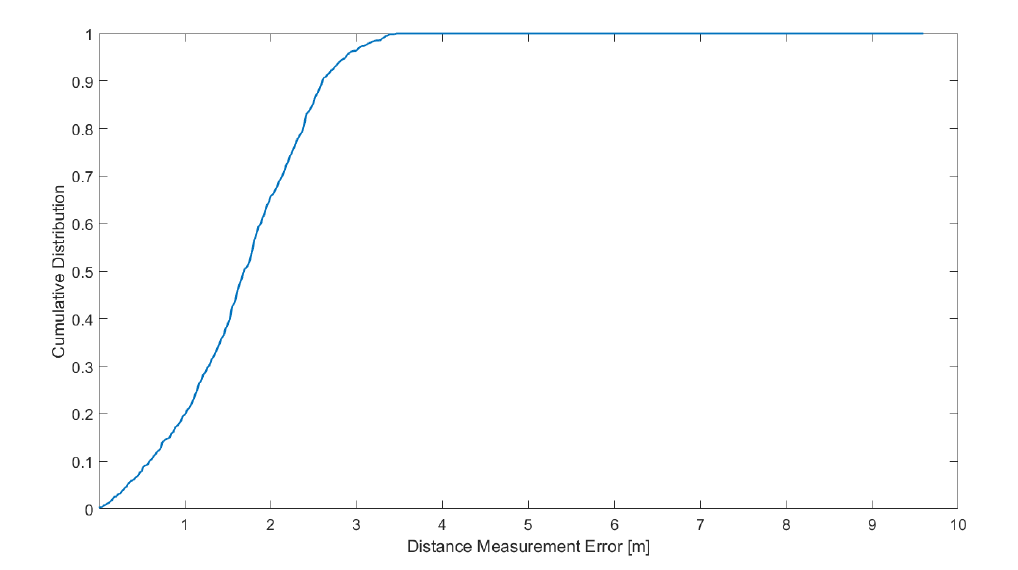
Figure 13. CDF of coarse range finding